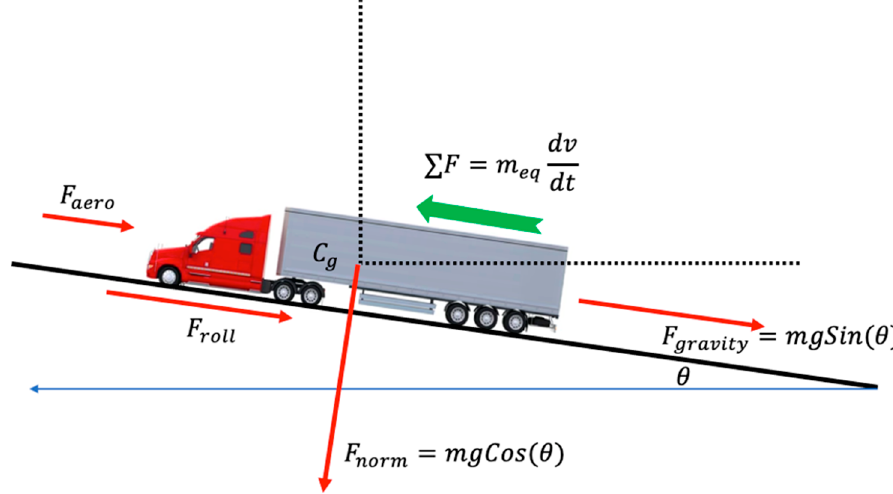
Figure 2. 1D longitudinal forces on a vehicle.